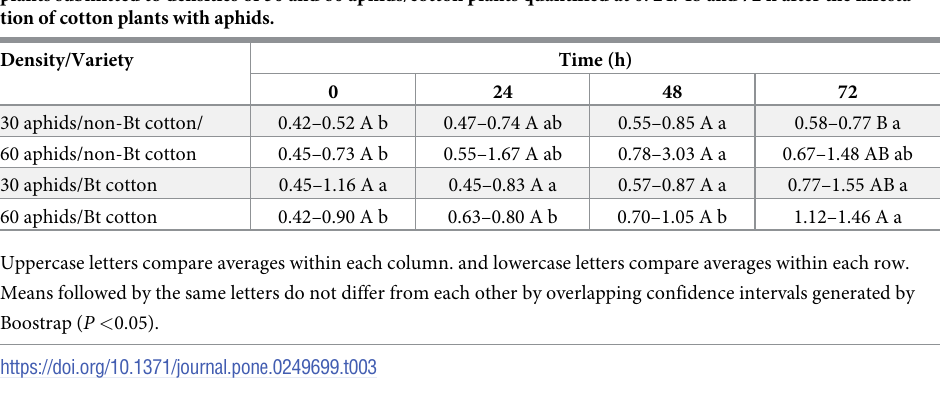
Table 3. Confidence intervals associated with the A . gossypii aggregation index (95% CI) in Bt and non-Bt cotton plants submitted to densities of 30 and 60 aphids/cotton plants quantified at 0. 24. 48 and 72 h after the infesta- tion of cotton plants with aphids.